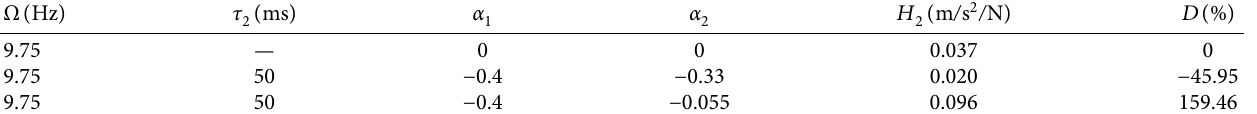
� − 0 . 4, and τ � 50ms. 1 2